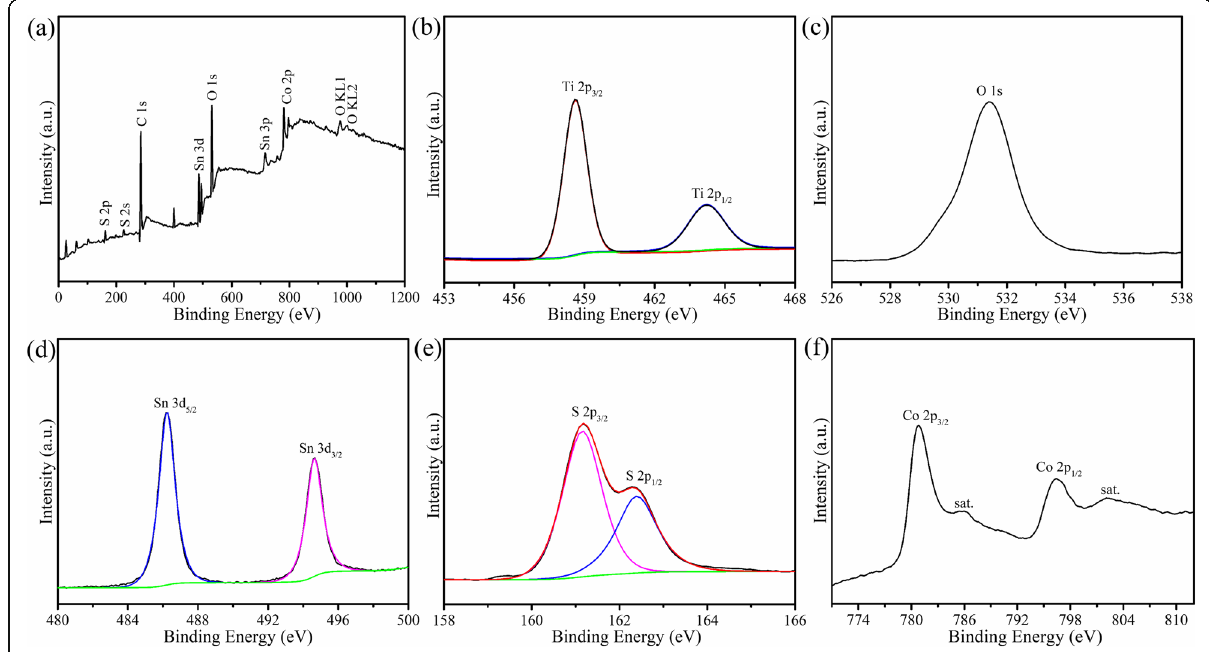
Fig. 3 XPS survey spectra ( a ), high-resolution XPS spectra of b Ti 2p, c O 1s, d Sn 3d, e S 2p, and f Co 2p for TiO 2 /SnS 2 /CoO x composite nanosheet